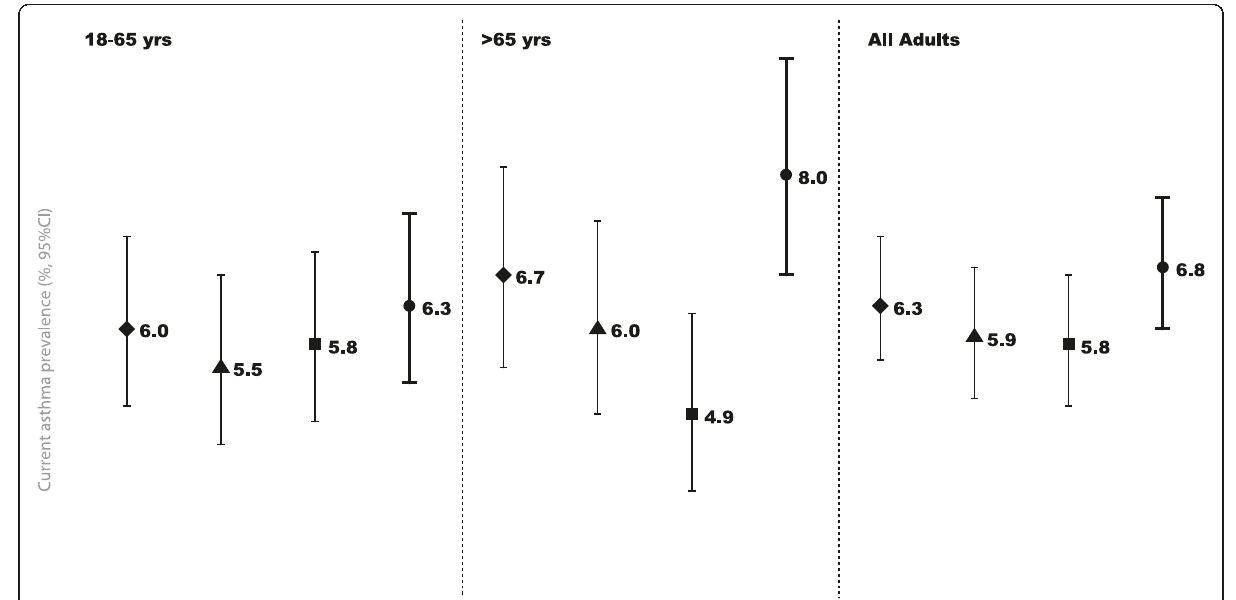
Figure 2 Current asthma prevalence in subgroups of adults by symptoms possible to affect the estimates. Symbols represent the prevalence of ‘ Current asthma ’ in people: ♦ without chronic bronchitis; ▲ who smoked ≤ 10 packs-year; ■ without self reported heart disease and ● all participants of the age group.